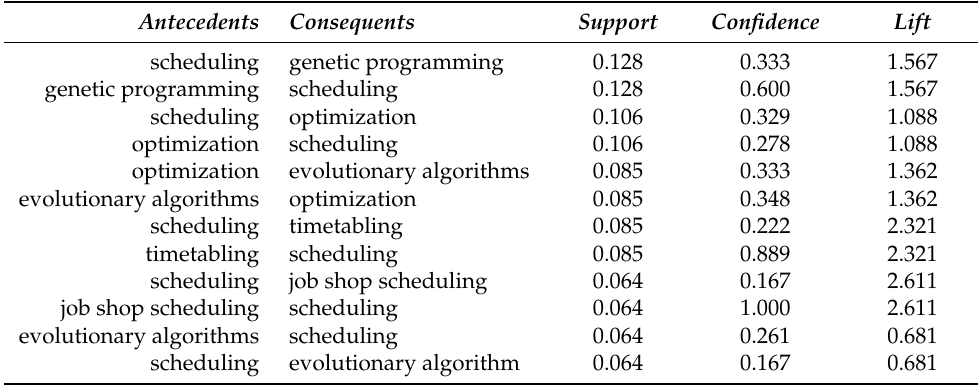
Table 4. Association rules of index keywords in the 90th percentile of the most-cited articles on hyper-heuristic-related